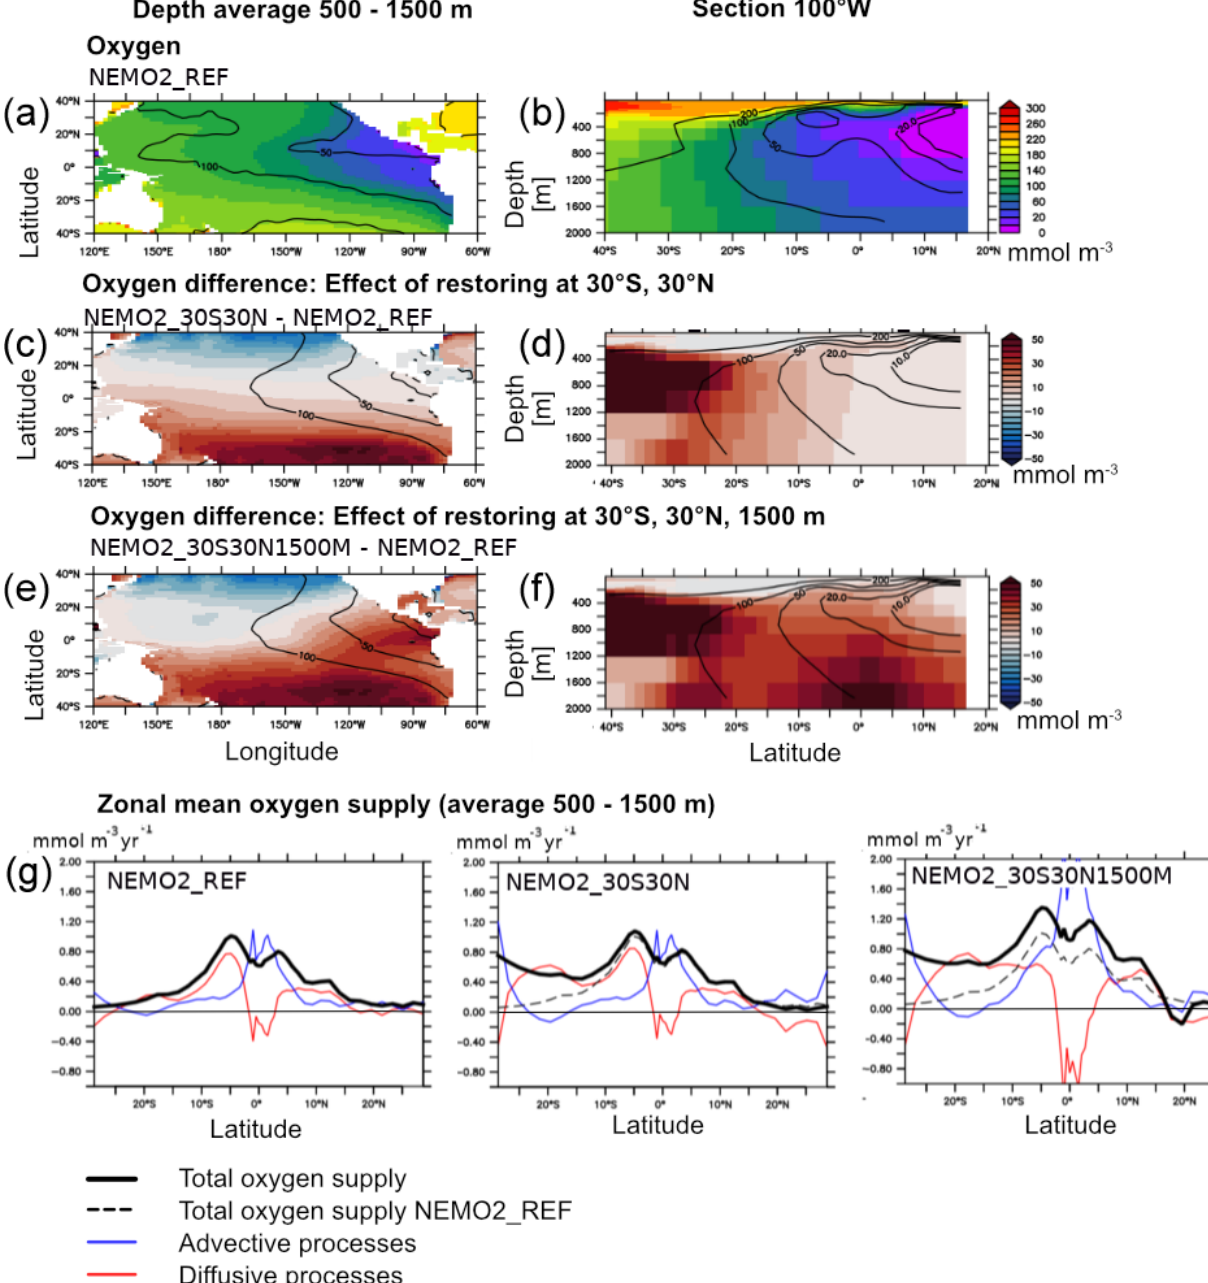
Figure 3. (a, b) Oxygen (mmolm − 3 ) in the experiments NEMO2_REF (color) and World Ocean Atlas (contour) ( a average 500–1500m, b 100 ◦ W). (c, d) Oxygen (mmolm − 3 ) difference ( c average 500–1500m, d 100 ◦ W) between the experiments NEMO2_30S30N minus NEMO2_REF. (e, f) Oxygen (mmolm − 3 ) difference ( e average 500–1500m, f 100 ◦ W) between the experiments NEMO2_30S30N1500M minus NEMO2_REF. (g) Basin zonal average (average 500–1500m) of the total oxygen supply (bold) (mmolm − 3 yr − 1 ), advective processes (blue), and isopycnal diffusion (red) in NEMO2_REF, NEMO2_30S30N, and NEMO2_30S30N1500M. The dashed line is the total oxygen supply in